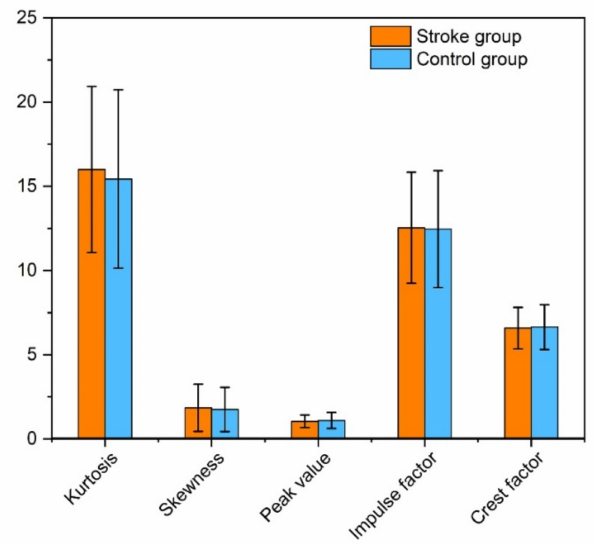
Figure 5. Bar graph illustration of the mean and standard deviation values of the statistical and impulsive metric variables of the stroke and control groups.